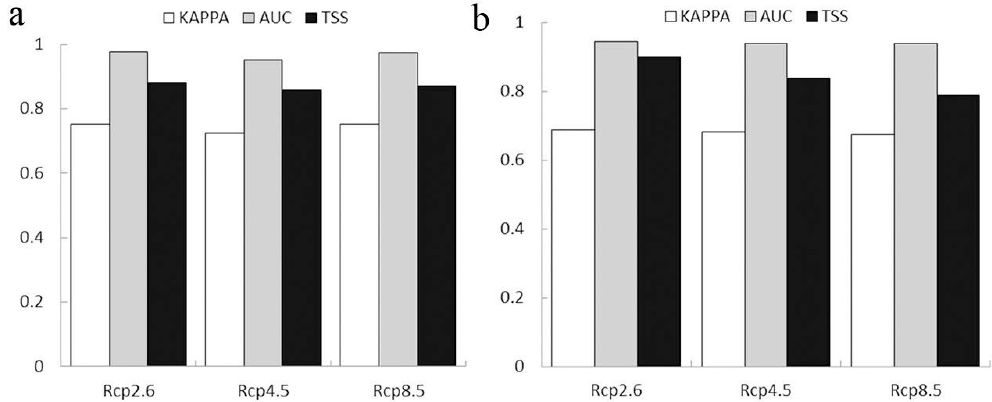
Figure 4. Evaluation of prediction model under different RCPs in 2050s ( a ), and 2070s ( b ).